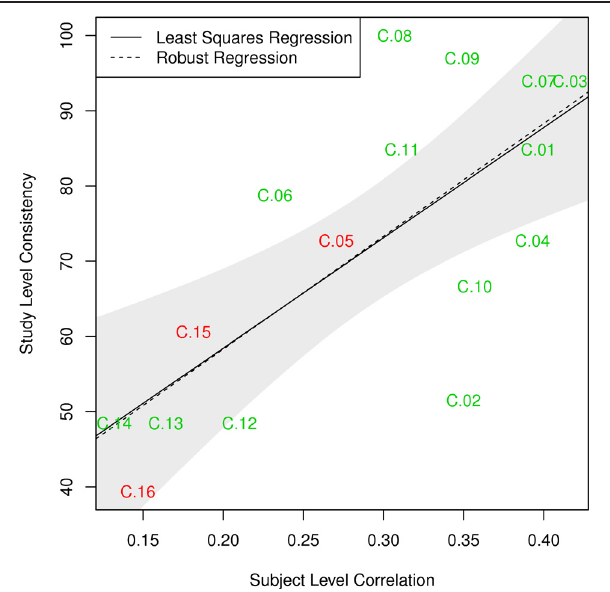
FIGURE 9 | Scatterplot showing a linear relationship between scan duration in seconds and median number of components per subject identified in each individual study using LAP criterion in FSL MELODIC. Note that both ordinary least squares (OLS) and the robust MM-estimator identify the same relationship, highlighting the robustness of this ratio ( p < 10 − 4 for both estimators). The shaded area corresponds to a 95% confidence interval for the OLS